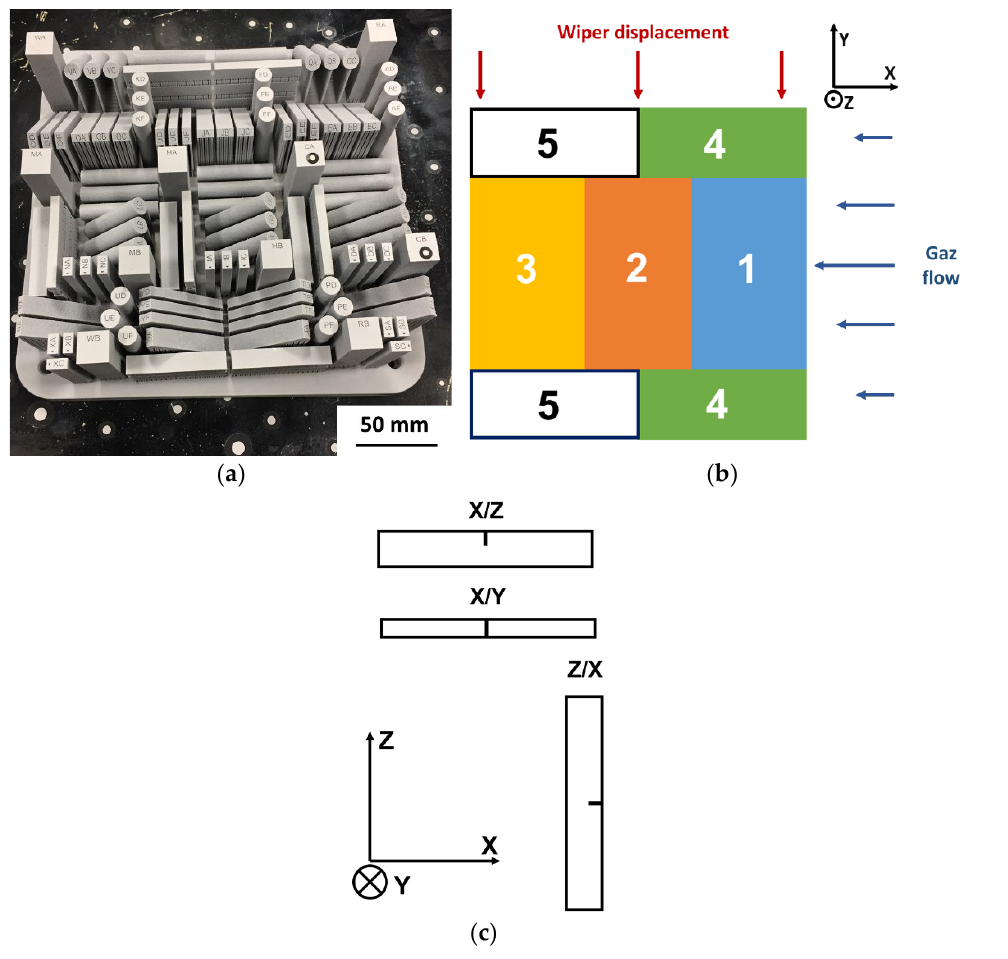
Figure 1. ( a ) Manufacturing of the study parts. ( b ) Configuration of the fabrication (gas flow and wiper displacement directions) and representation of the different zones considered on the surface of the building plate. ( c ) Depiction of building and notch orientations for Charpy tests specimens.